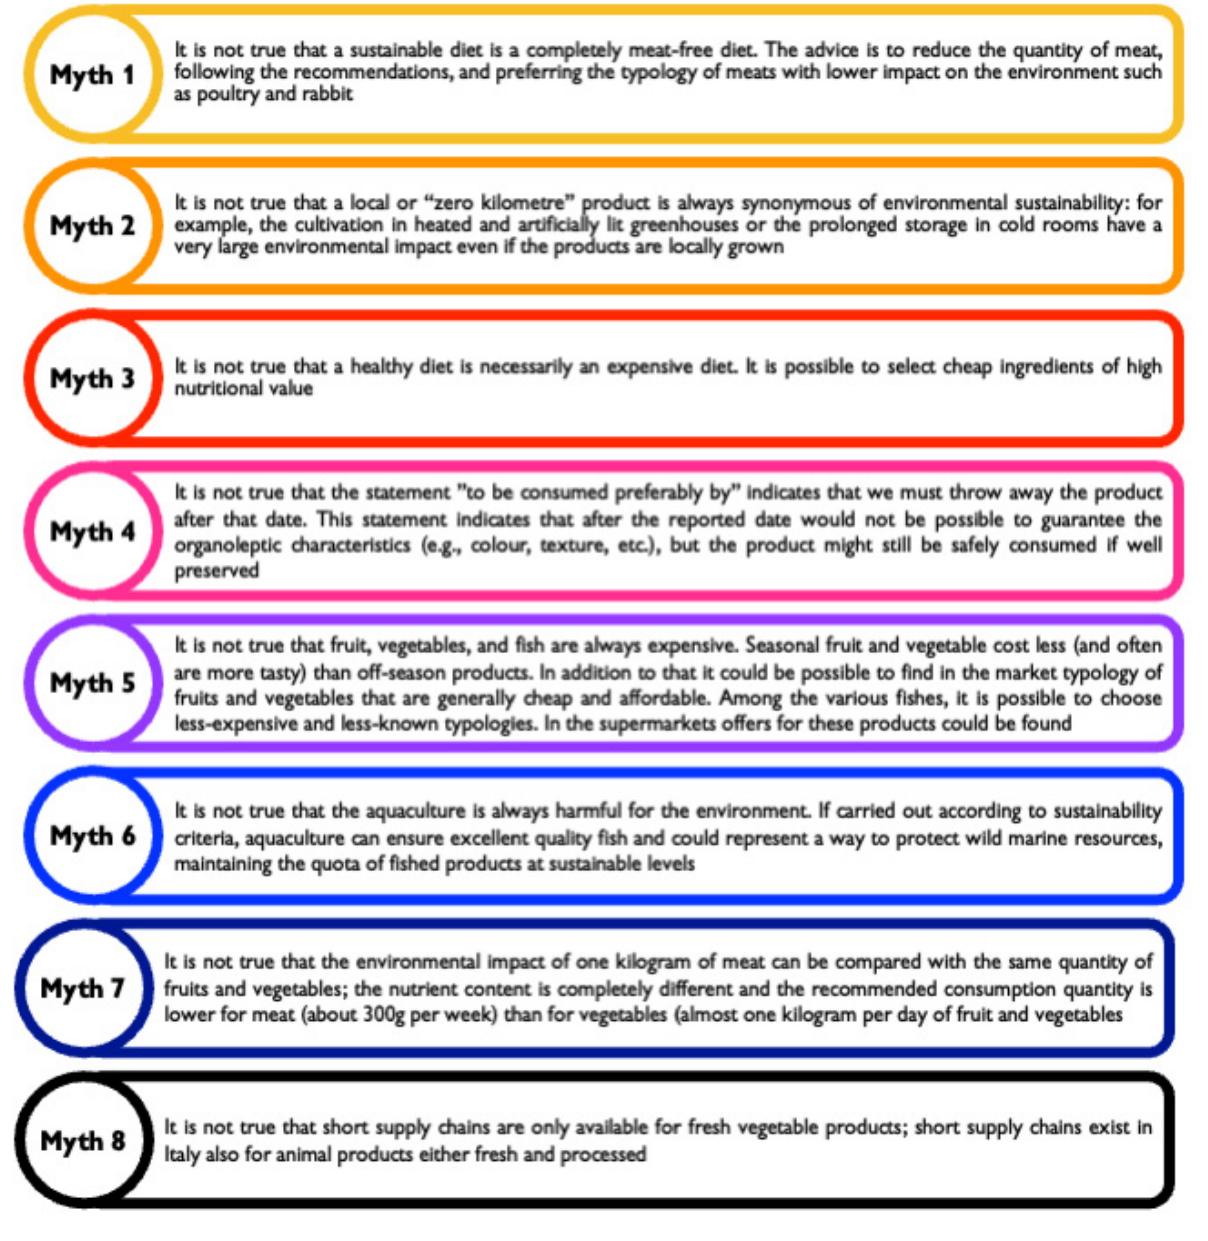
Figure 3. Myths and false beliefs on the sustainable diets.